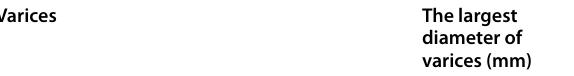
Table 1 Esophageal varices are graded by CT according to the followings: